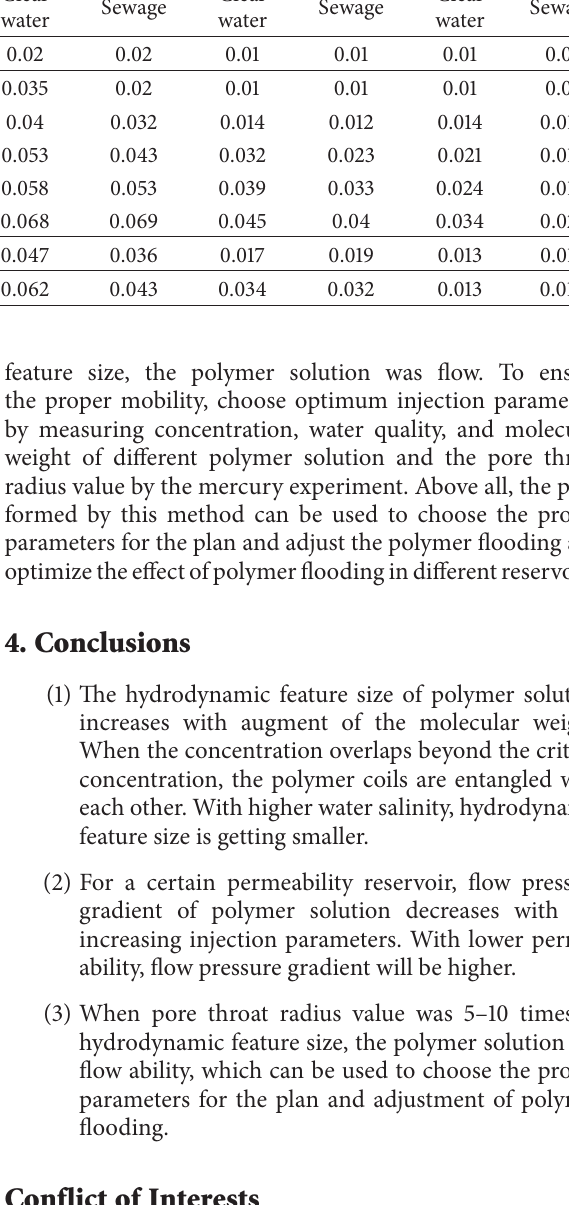
Table 2: The result of the flow pressure gradient of different parameter polymer solution in different permeability cores (MPa/m). MW, 10 4 𝐶 , mg/L